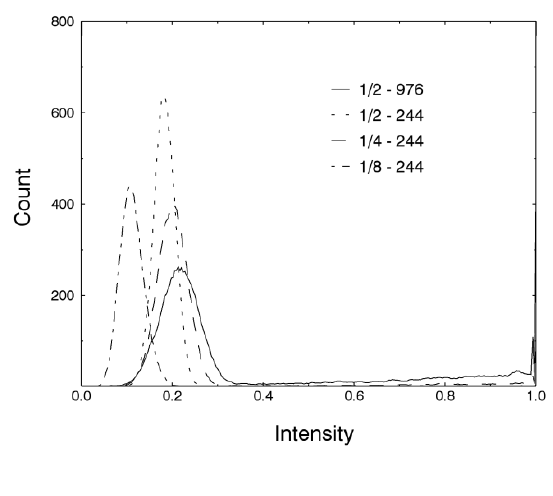
Figure 5. Intensity histograms of sky points retrieved from test scan regions with different scan parameters (scan resolution and measurement